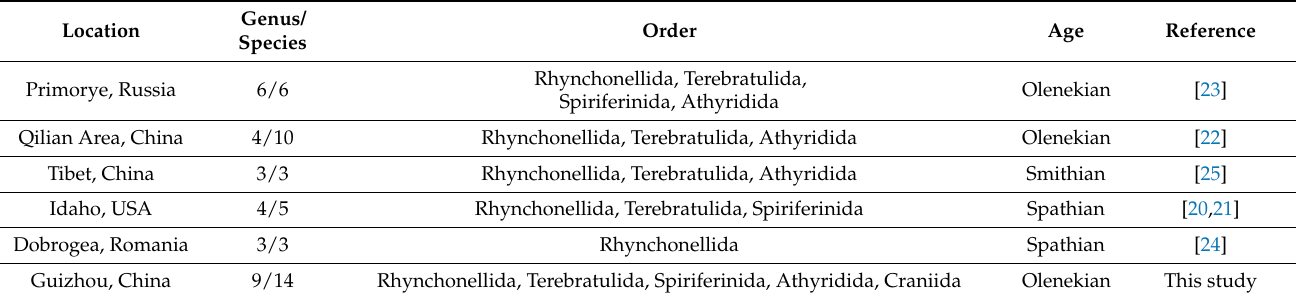
Table 1. Main Olenekian brachiopod fauna worldwide, fauna with only one or two species not included